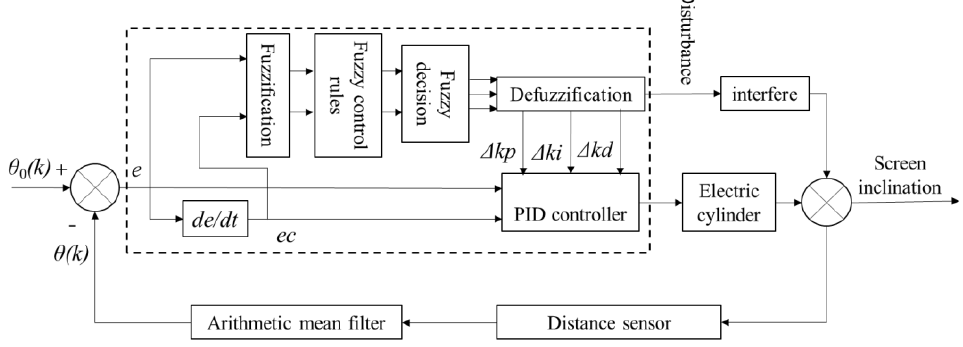
Figure 6. Structure of the fuzzy PID controller.